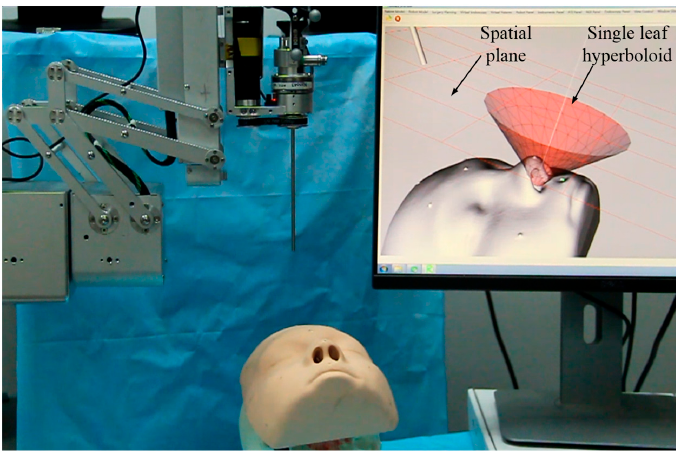
Figure 12. Experiment scene of the FRVFs.